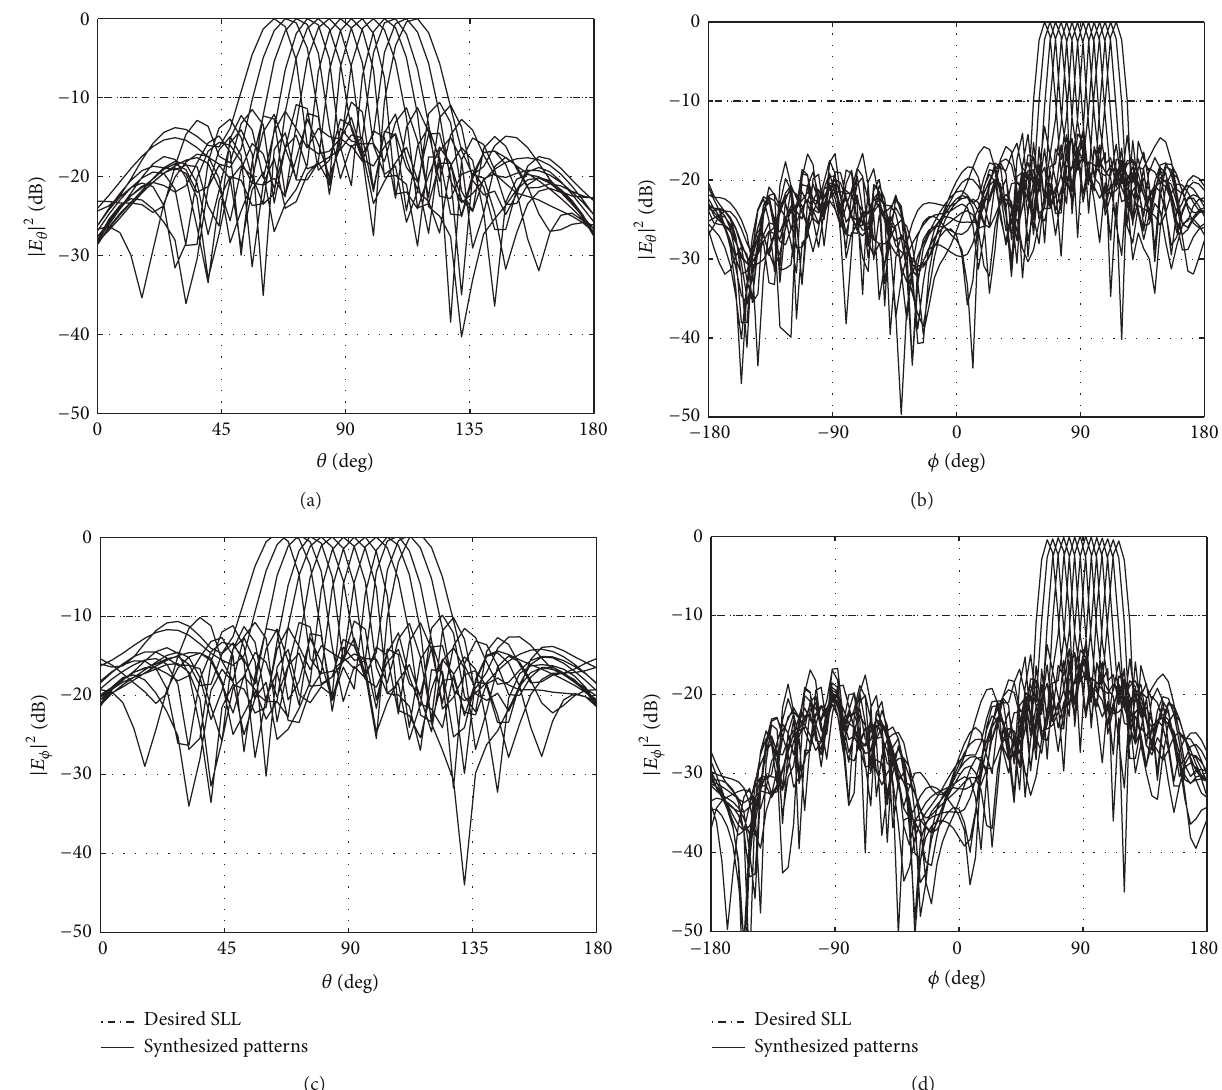
Figure 4: Patterns obtained for a two-dimensional scanning of the region [64 ∘ , 116 ∘ ]×[64 ∘ , 116 ∘ ] using the proposed algorithm by phase-only control with 𝑐 = 0 : (a) |𝐸 𝜃 | 2 for 𝜙 = 88 ∘ , (b) |𝐸 𝜃 | 2 for 𝜃 = 88 ∘ , (c) |𝐸 𝜙 | 2 for 𝜙 = 88 ∘ , and (d) |𝐸 𝜙 | 2 for 𝜃 = 88 ∘ .